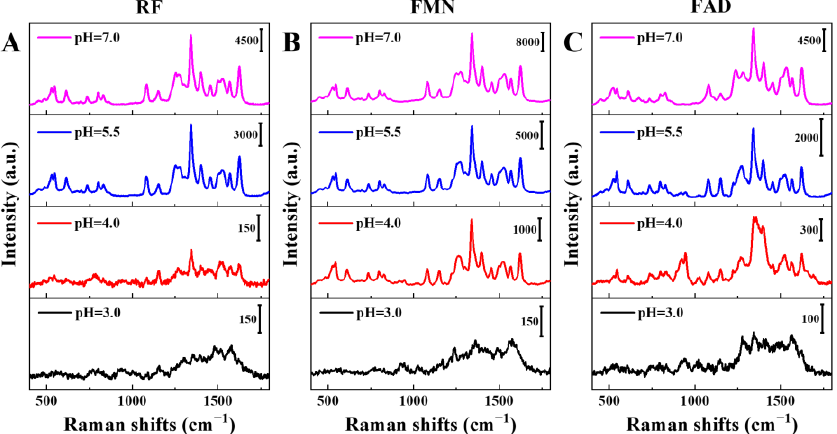
Figure 7. The 532-nanometer-laser Raman spectra of RF ( A ), FMN ( B ), and FAD ( C ) on Ag nanofilms under pH of 3.0, 4.0, 5.5, and 7.0, respectively.